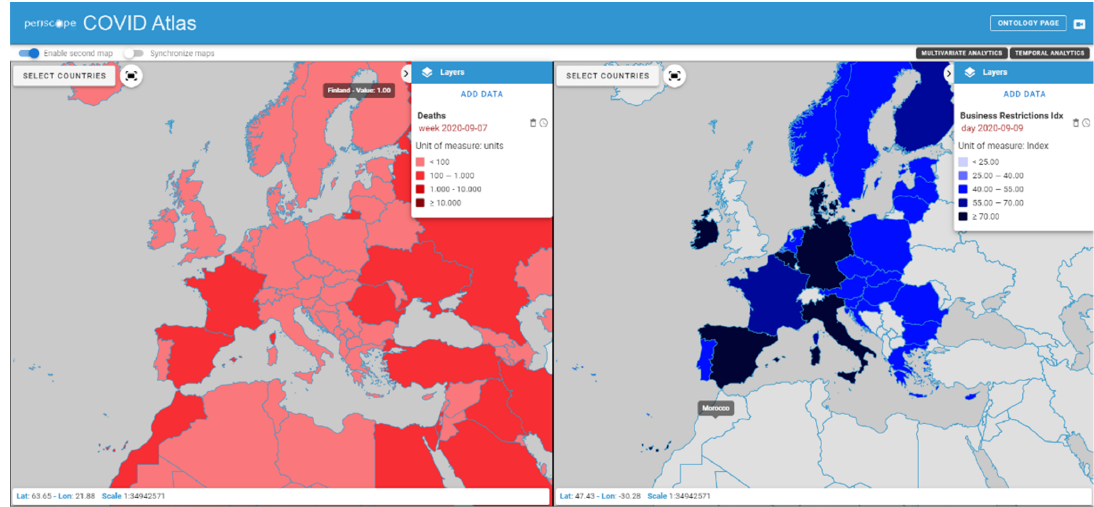
Figure 5. A sample page of the Atlas WebGIS with side-by-side visualization of two maps, one showing the number of deaths ( left side ) and the other showing the Business Rrestiction Index ( right side ) for the same week.